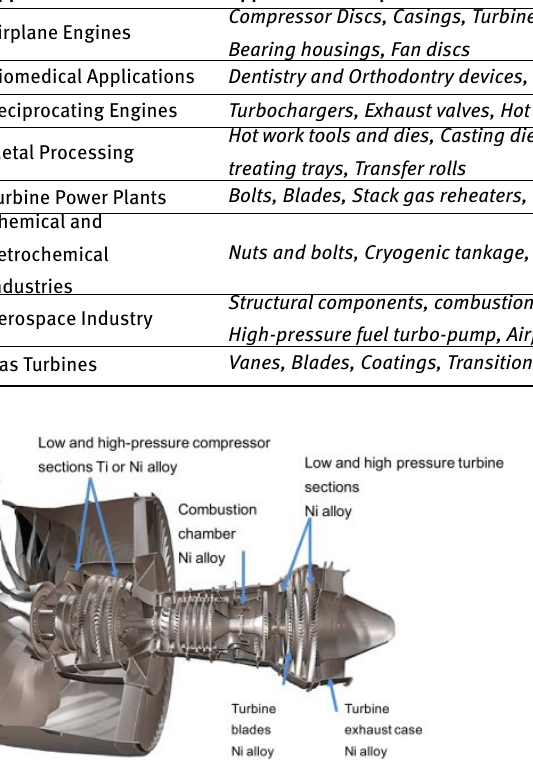
Table 1: A brief overview of applications of superalloys in various industries Application Sector